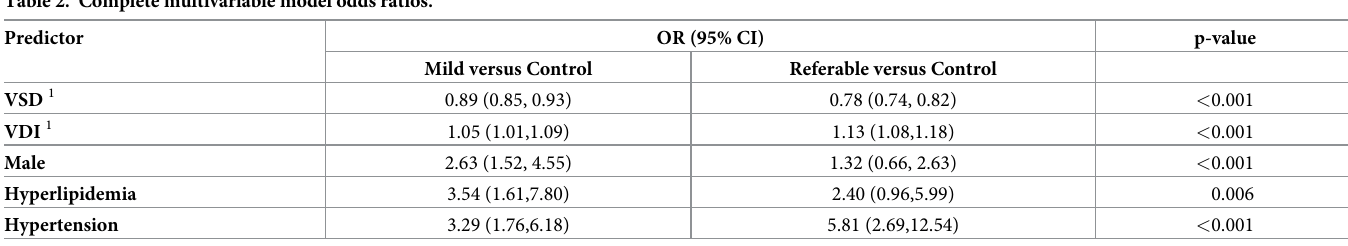
Table 2. Complete multivariable model odds